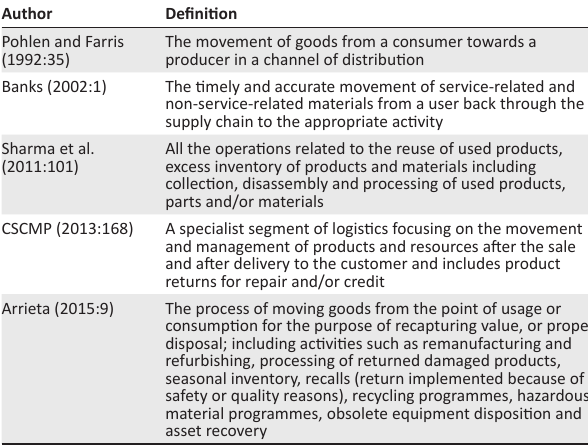
TABLE 1: Definitions of reverse